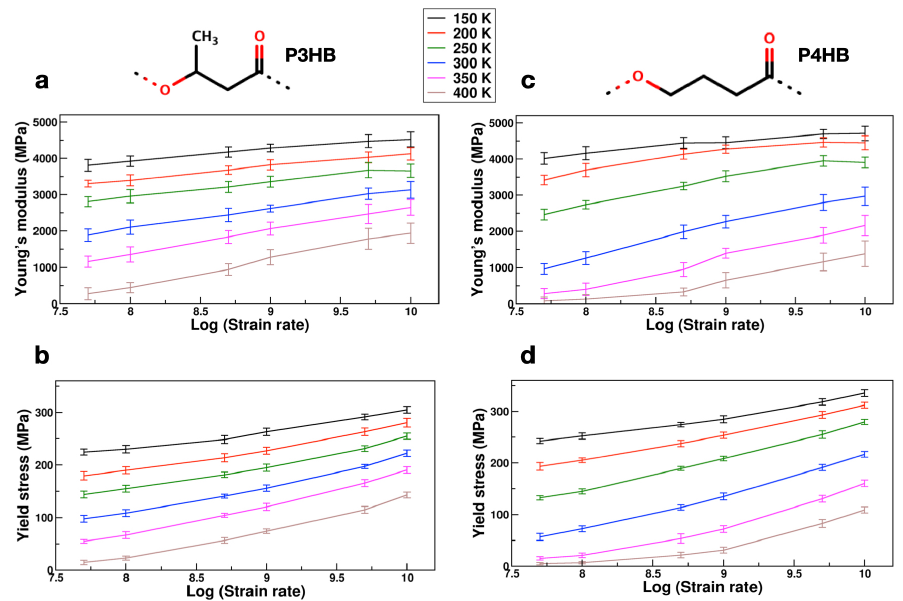
Figure 2. Variation of Young’s modulus and yield stress values (in MPa) with temperature and applied strain rates. Two polymer chemistries P3HB and P4HB were considered for this study and their chemical structures shown in the top panel. ( a , b ) Young’s modulus and yield stress values for P3HB; ( c , d ) Young’s modulus and yield stress values for P4HB. For each data set, a total of 15 simulations were performed using 5 independently generated amorphous polymer structures and applying strain in 3 different directions for each amorphous polymer